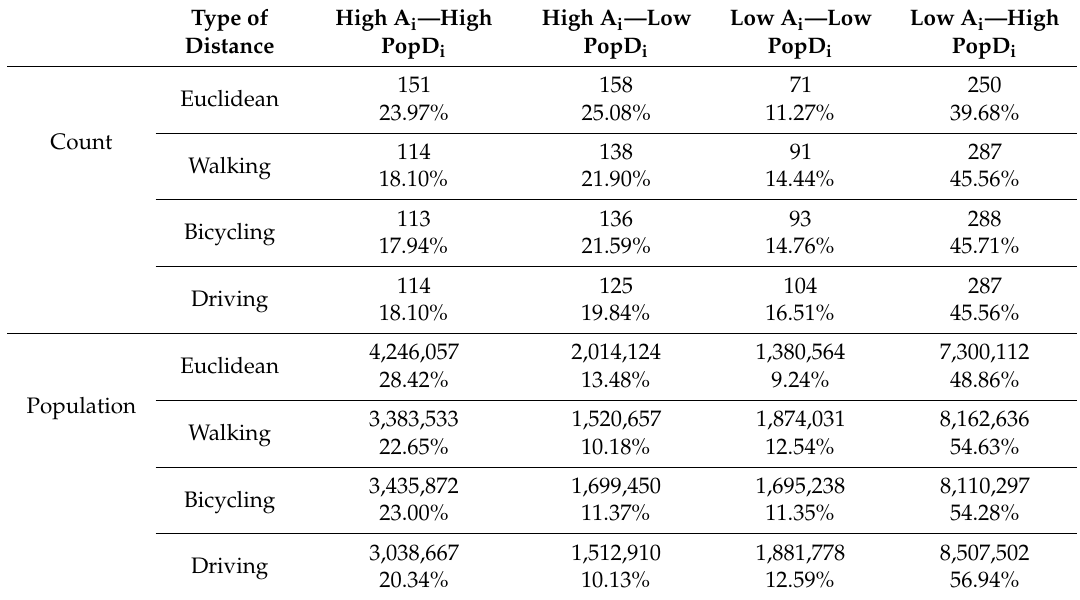
Table 5. Summary of the associations between park accessibility (Ai) and population density